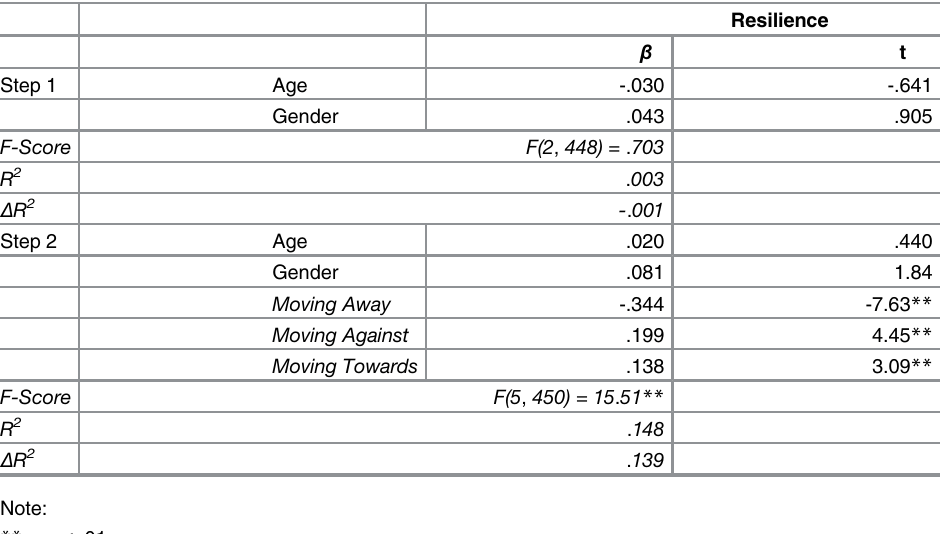
Table 8. Regression of Age, Gender, and three higher-order HDS Dark Side facets as predictors of Resilience